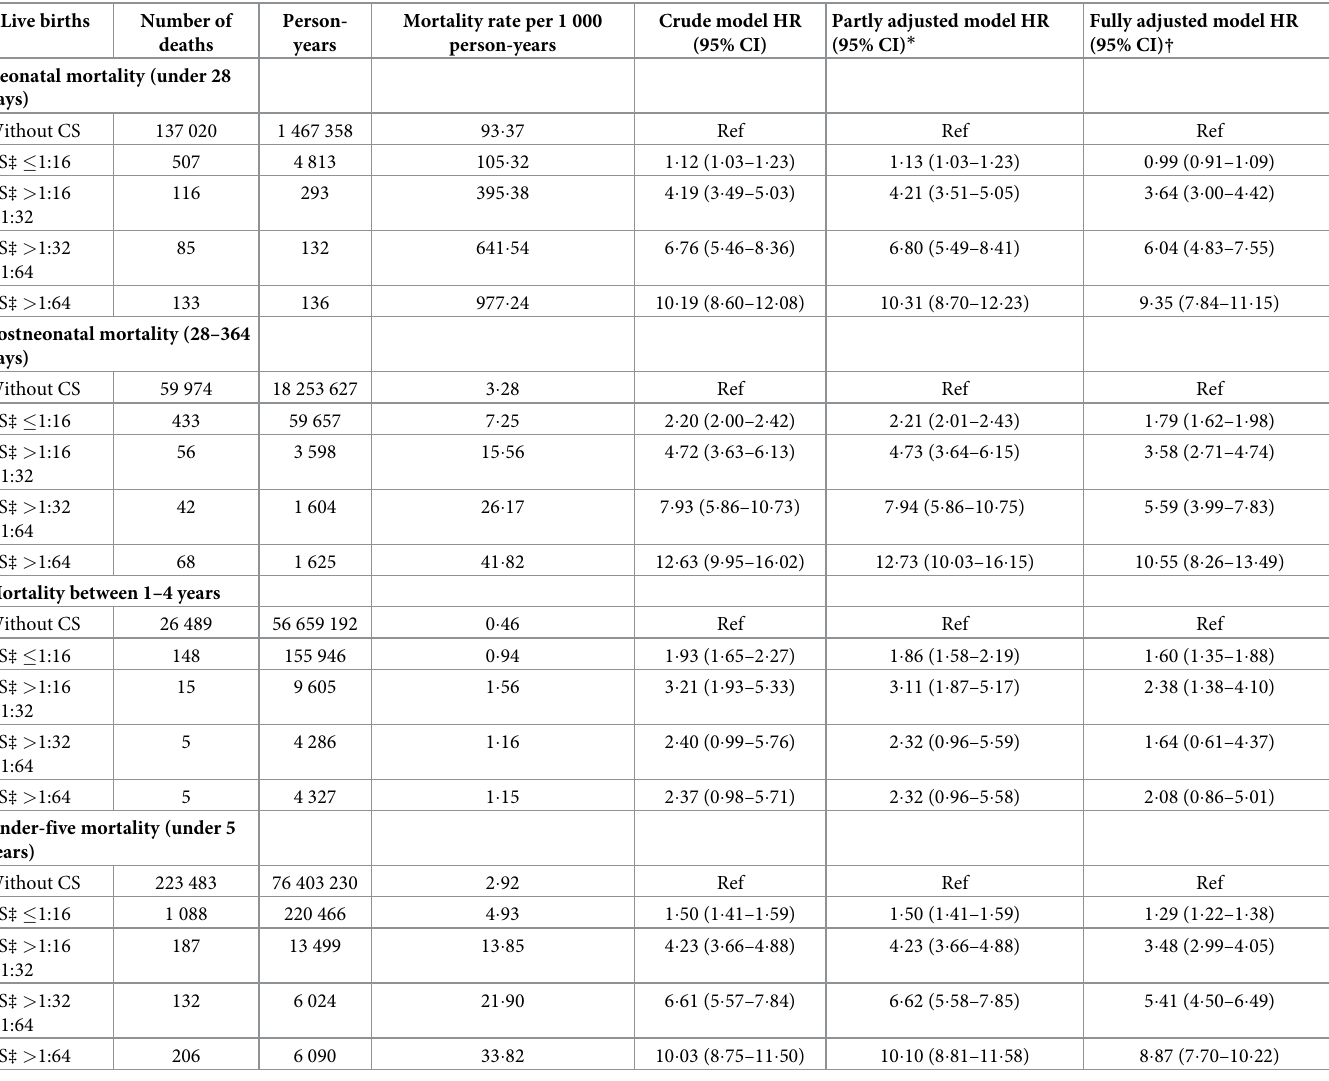
Table 4. Mortality risk by age group and non-treponemal titers among singleton live births in the cohort-linked data, Brazil, 2011–2017. Live births Number of